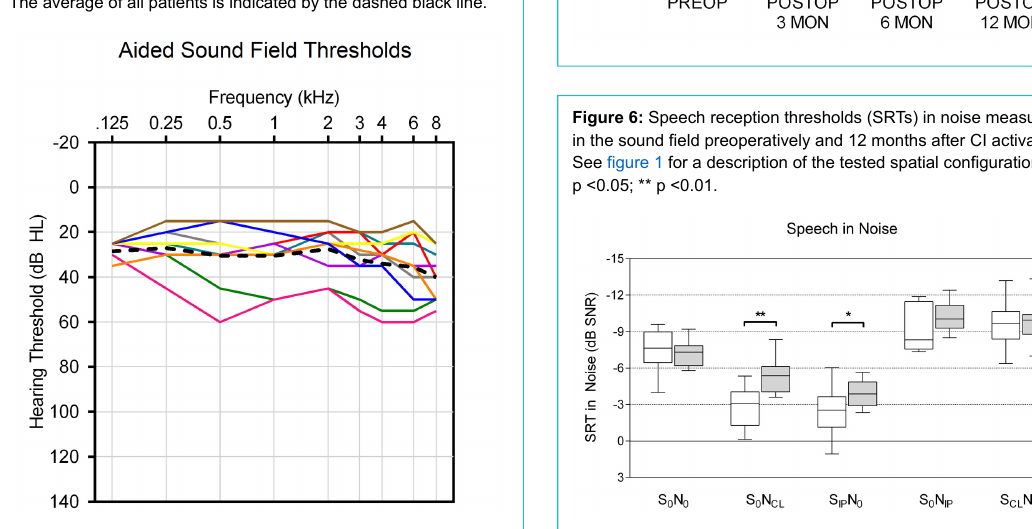
Figure 4: CI-aided sound field hearing thresholds assessed 12 months post activation with the normal ear plugged and muffed. The average of all patients is indicated by the dashed black line.